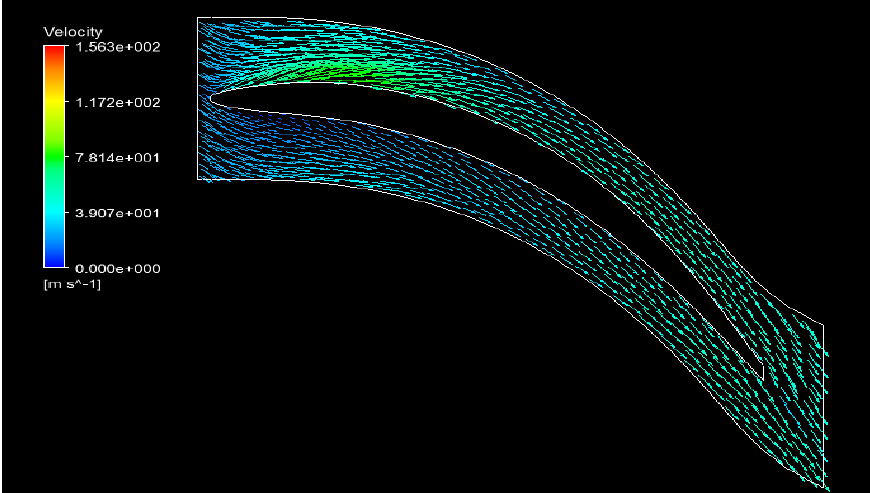
Figure 32. CFD study results: Velocity mid-spam detail (R-245fa).